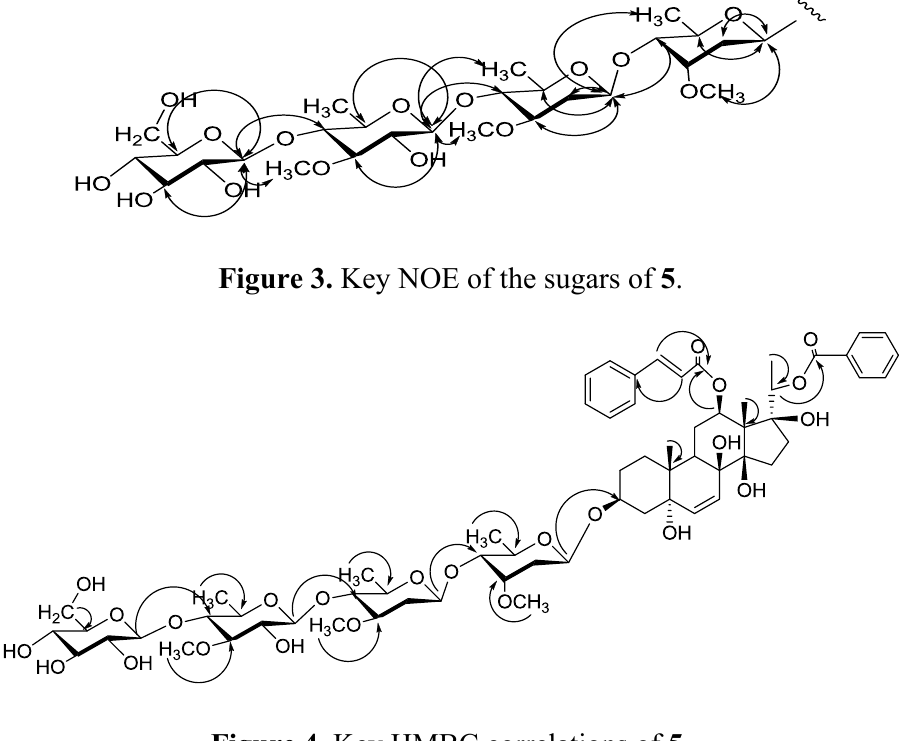
Figure 4. Key HMBC correlations of 5